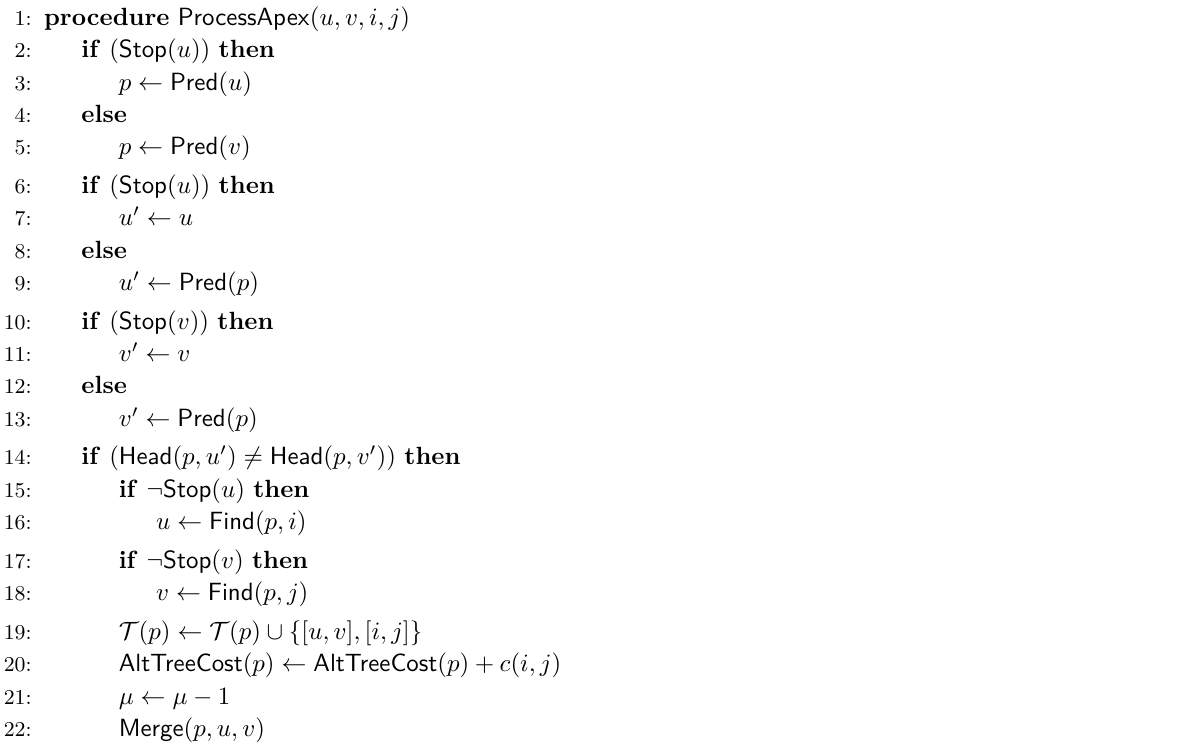
Algorithm 10 The procedure that inserts horizontal